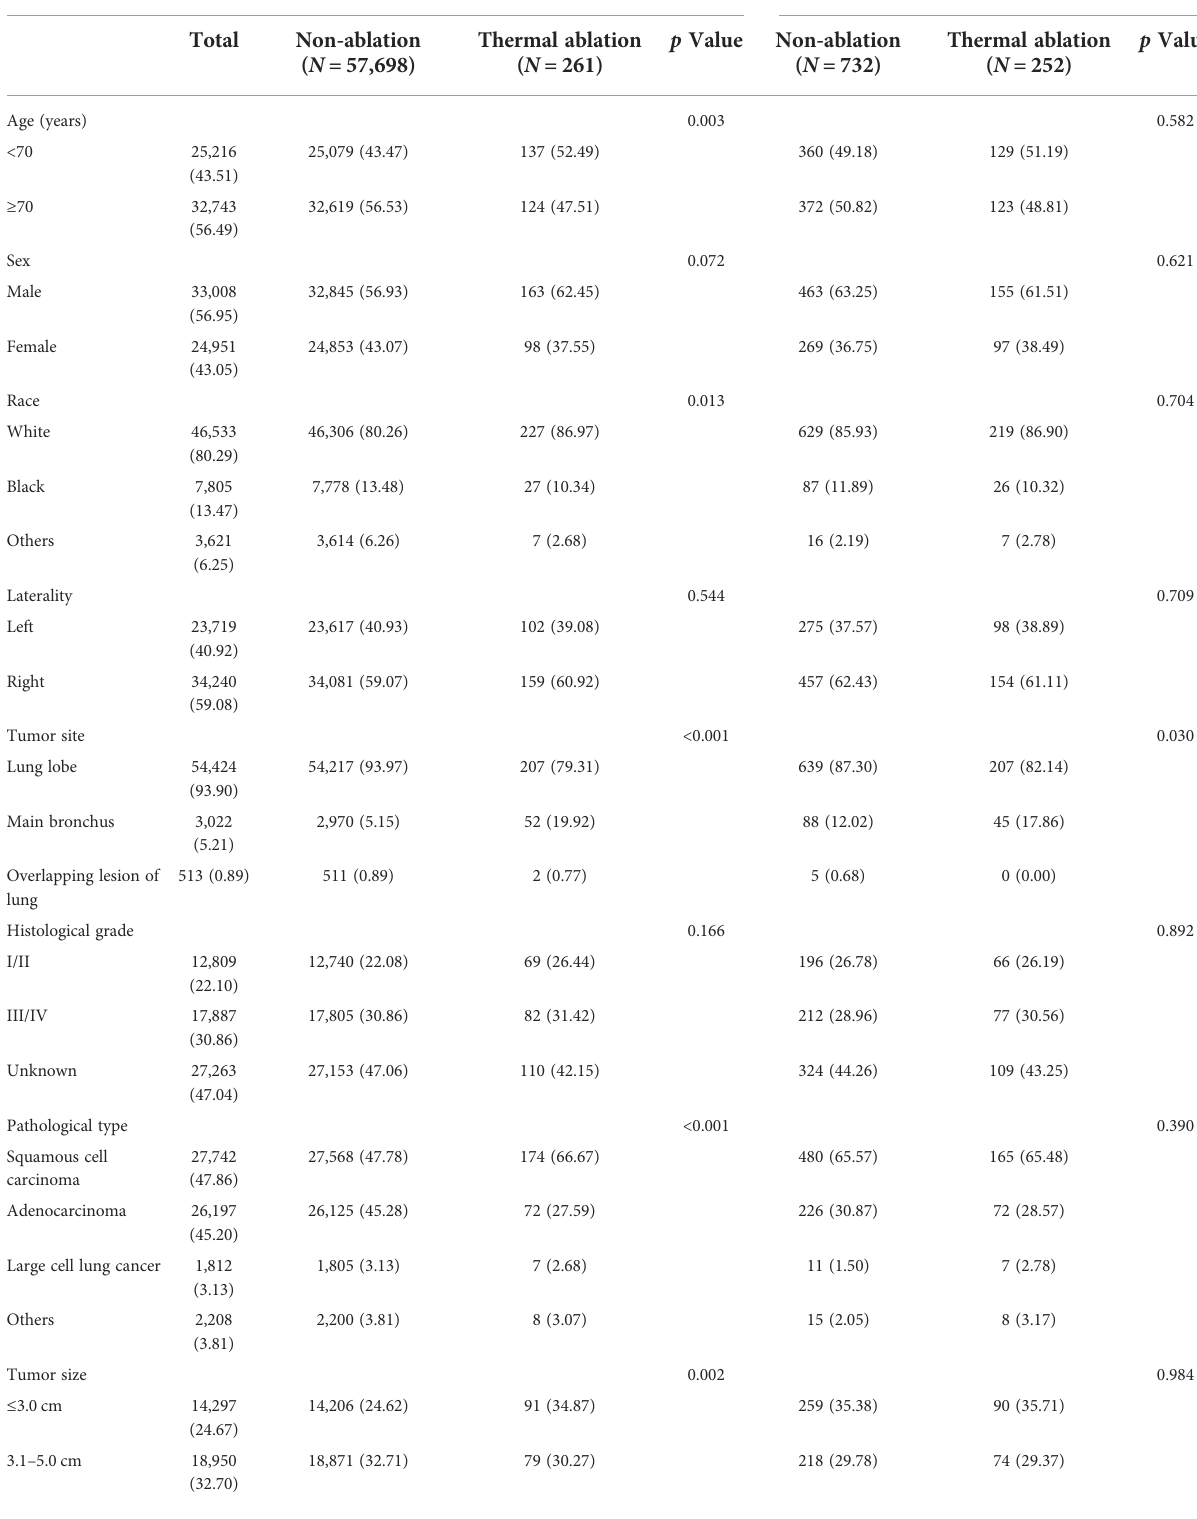
TABLE 1 Characteristics of stage II-III NSCLC patients before and after PSM, n